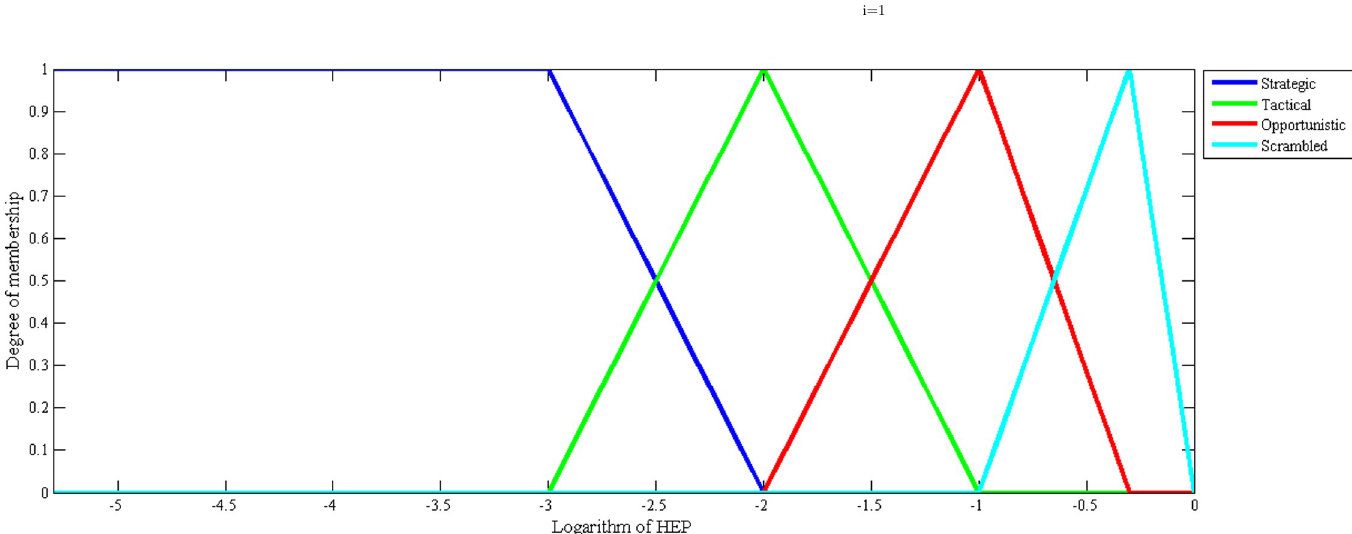
Fig 2. Membership curves of each